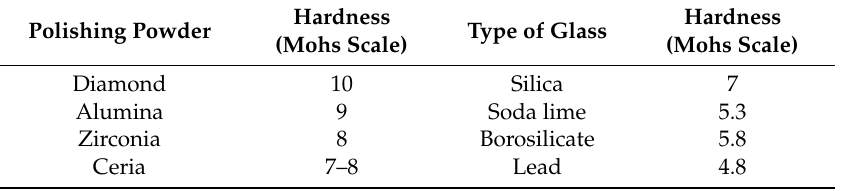
polishing agent compared to other oxides such as zirconia and alumina. Table 1. Hardness values of different polishing powders and different type of glasses [9].